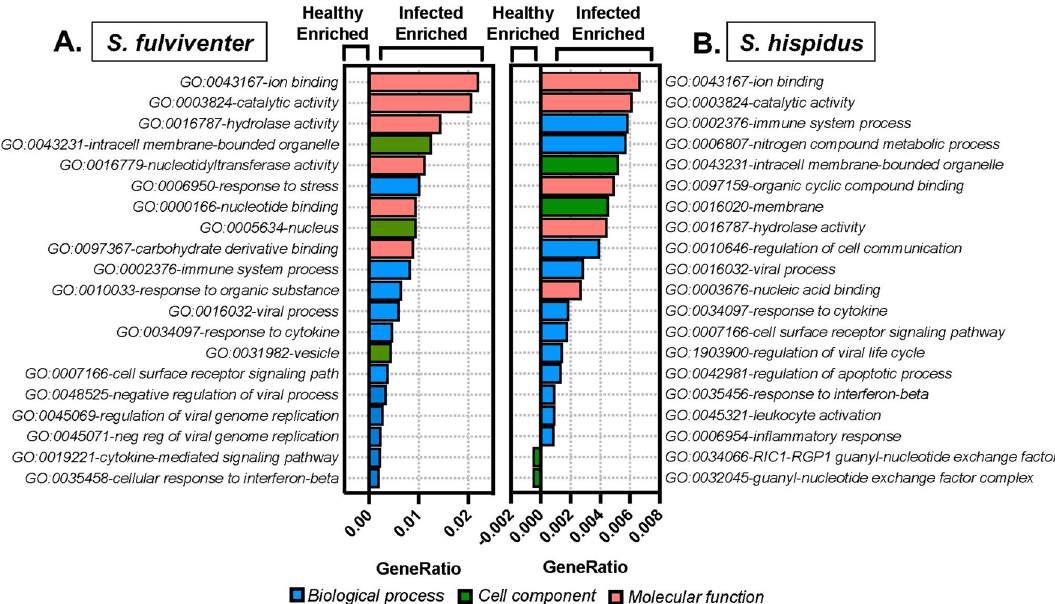
Figure 5. Categorical changes in gene expression after RSV infection in both ( A ) S. fulviventer and ( B ) S. hispidus using Gene Ontology (GO) annotations and GoSeq. SwissProt GO terms on the y-axis (color coordinated based on biological process [blue], cell component [green], or molecular function [red]) with relative expression of GOs on the x-axis (expressed as GeneRatio, which is the proportion of differentially expressed genes in each GO category to the total number of differentially expressed genes in all significant GOs). Positive GeneRatio = enriched in RSV-infected lungs; negative GeneRatio = enriched in healthy lungs (no significant GOs in healthy S. fulviventer ). All GOs were statistically significant ( p < 0.05, q <